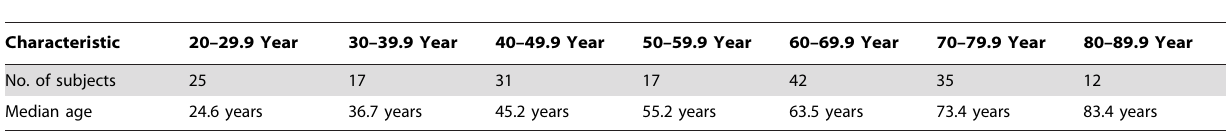
Table 1. Demographic characteristics of the subjects vaccinated with 2009–2010 seasonal inactivated trivalent vaccine.